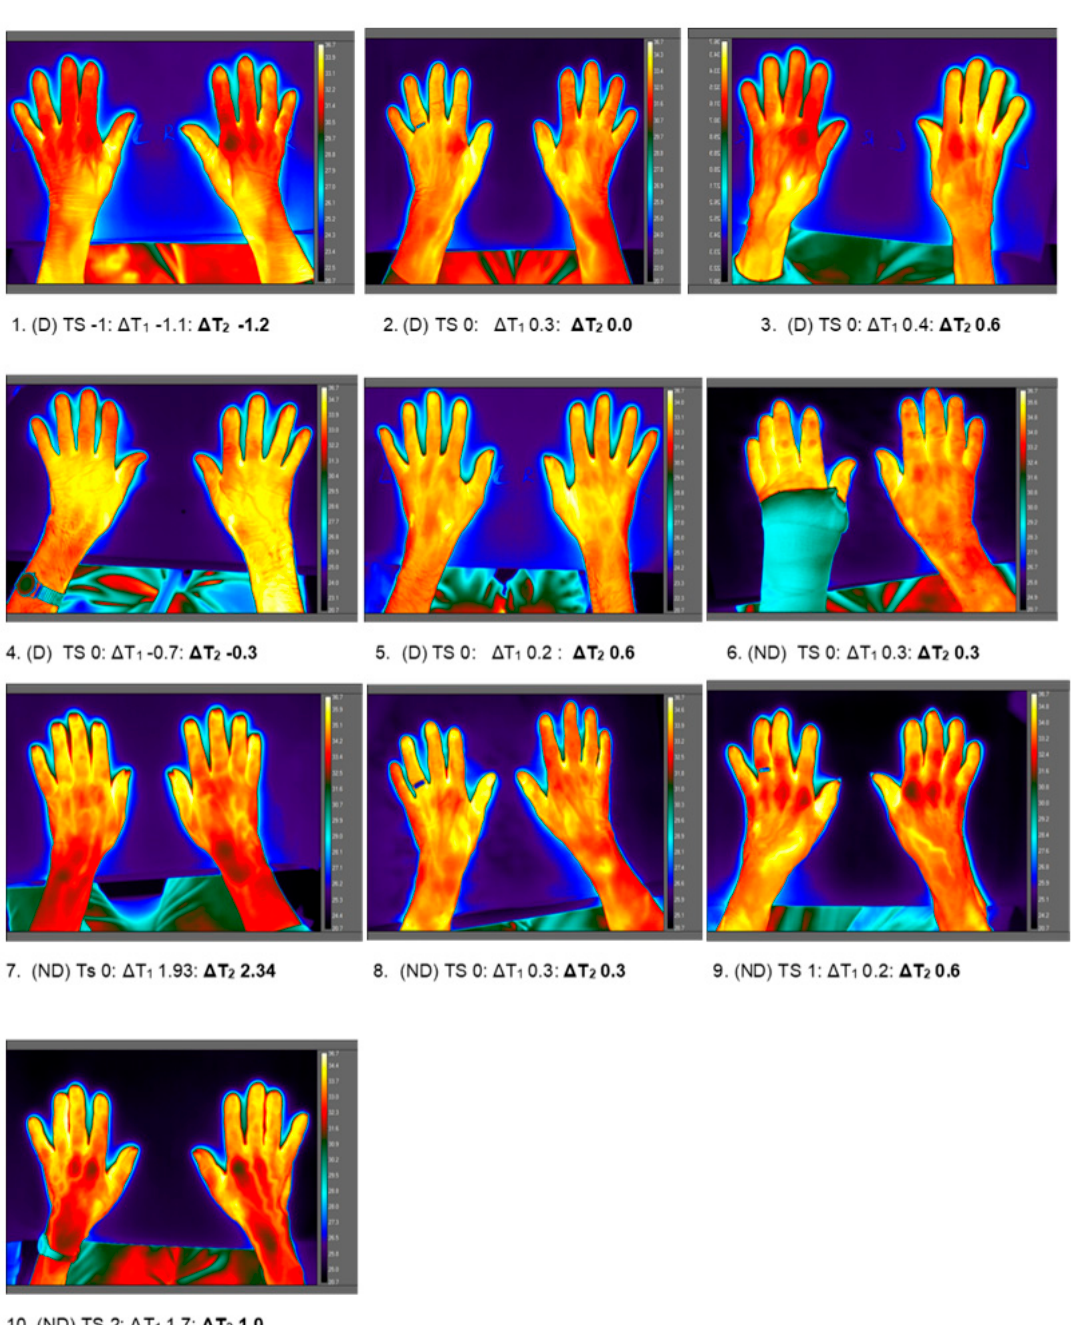
(B) ‘Warm hands’: By contrast (Figure 8) the brightest colour appearance visually on thermograms corresponded with highest hand temperatures in 10 residents (5 D; 5 ND) (mean T DP 31.7–35.2 ◦ median 33.7 C) across air temperature of 21.9 to those with cold hands. Individual thermal sensation ratings for this group were: − 1 (slightly cool, n = 1); 0 (comfortable / neutral, n = 7), 1 (slightly warm, n = 1) and 2 (warm, n = 1). Temperature di ff erence across the hands for ∆ T 1 ranged from − 1.1 mean temperature di ff erences between ROIs was small: range − 1.2